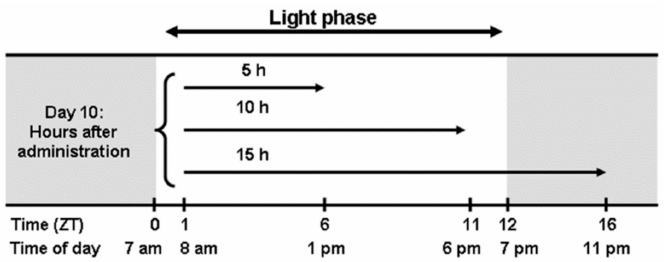
Figure 1. Chronic daily administration of cocaine and sucrose. Daily cocaine and sucrose adminis- tration was performed for 10 days at 8 am, 1 h after the beginning of the light phase ranging from Zeitgeber Time 0 (ZT0) = lights on to ZT12 = lights off. After 10 days, rats were sacrificed 5 h, 10 h and 15 h after the last administration at the indicated time denoted as ZT (6, 11 and 16) or time of the day. Zeitgeber time (ZT) is a standardized 24-h notation in which ZT0 indicates the beginning of the light phase and ZT12 is the beginning of the dark